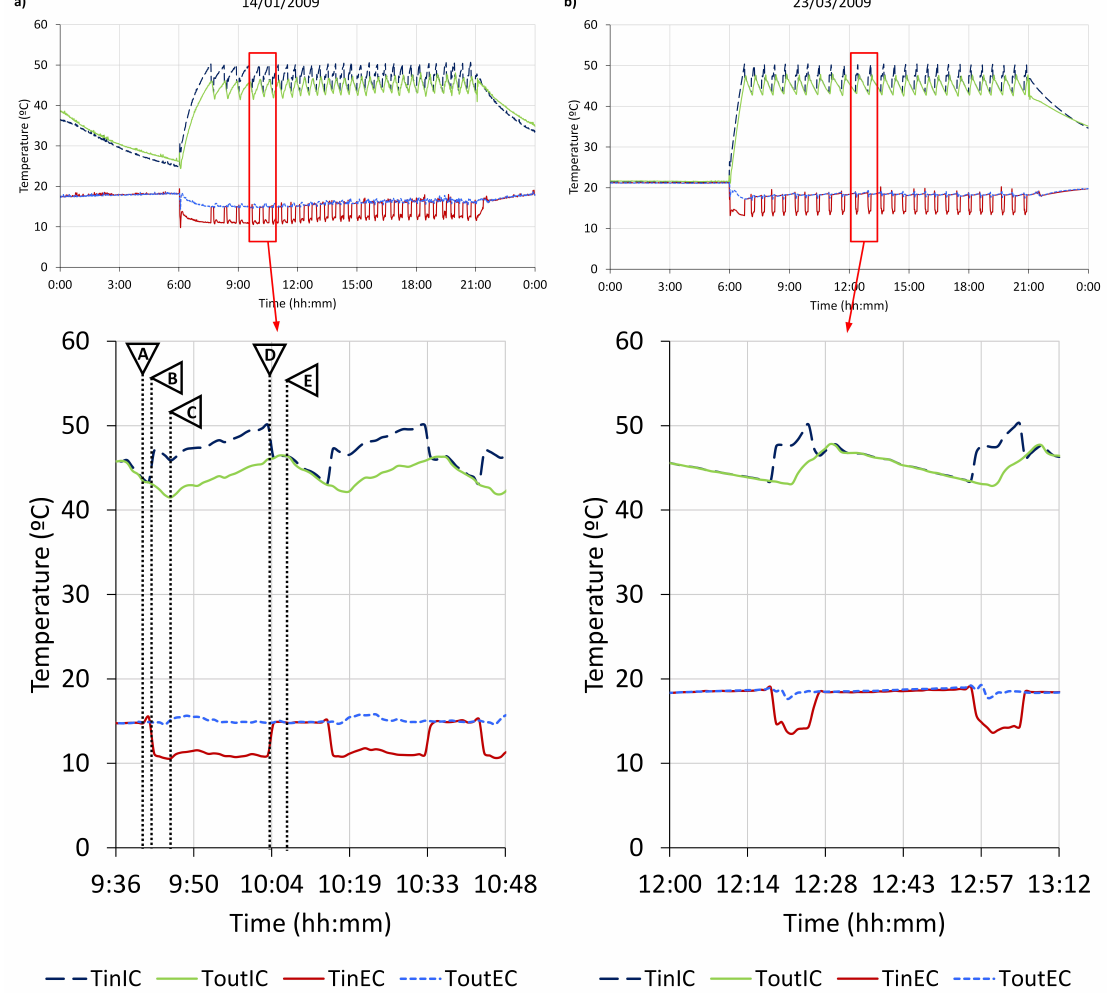
Figure 2. Daily temperature evolution in heating mode: ( a ) high load; and ( b ) low